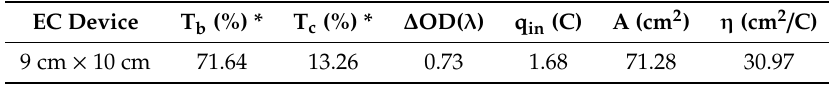
Table 2. Electrochromic properties of the fabricated device.